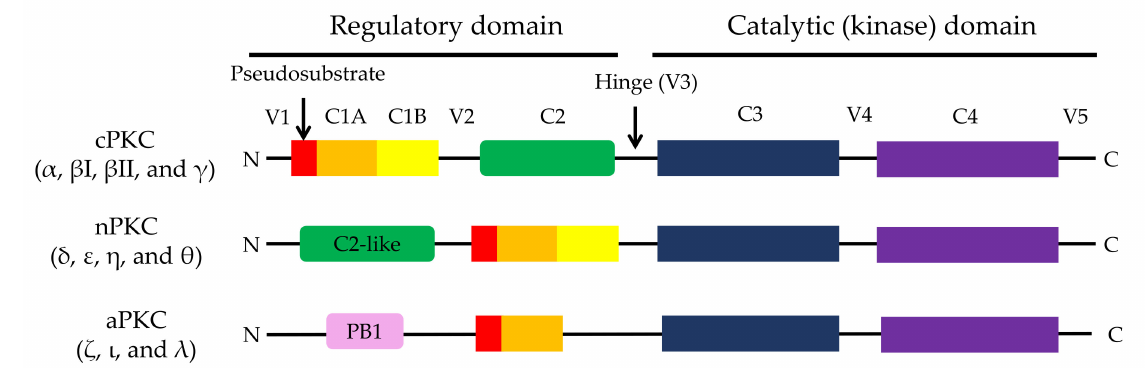
Figure 1. Structure of PKC isozymes. All PKCs consist of a regulatory domain, a catalytic (kinase) domain, and variable regions (V1–V5). The regulatory domain of all PKCs includes a C1 domain with a pseudosubstrate motif. Additionally, cPKCs, nPKC, and aPKCs have a C2 domain that binds to Ca 2+ , a C2-like domain that cannot bind to Ca 2+ , and a PB1 domain in the regulatory region, respectively. The C3 and the C4 domain of all PKCs bind to ATP and substrate, respectively. Reproduced with permission from Kang, J.H. et al., Biotechnol. Adv.; published by Elsevier,